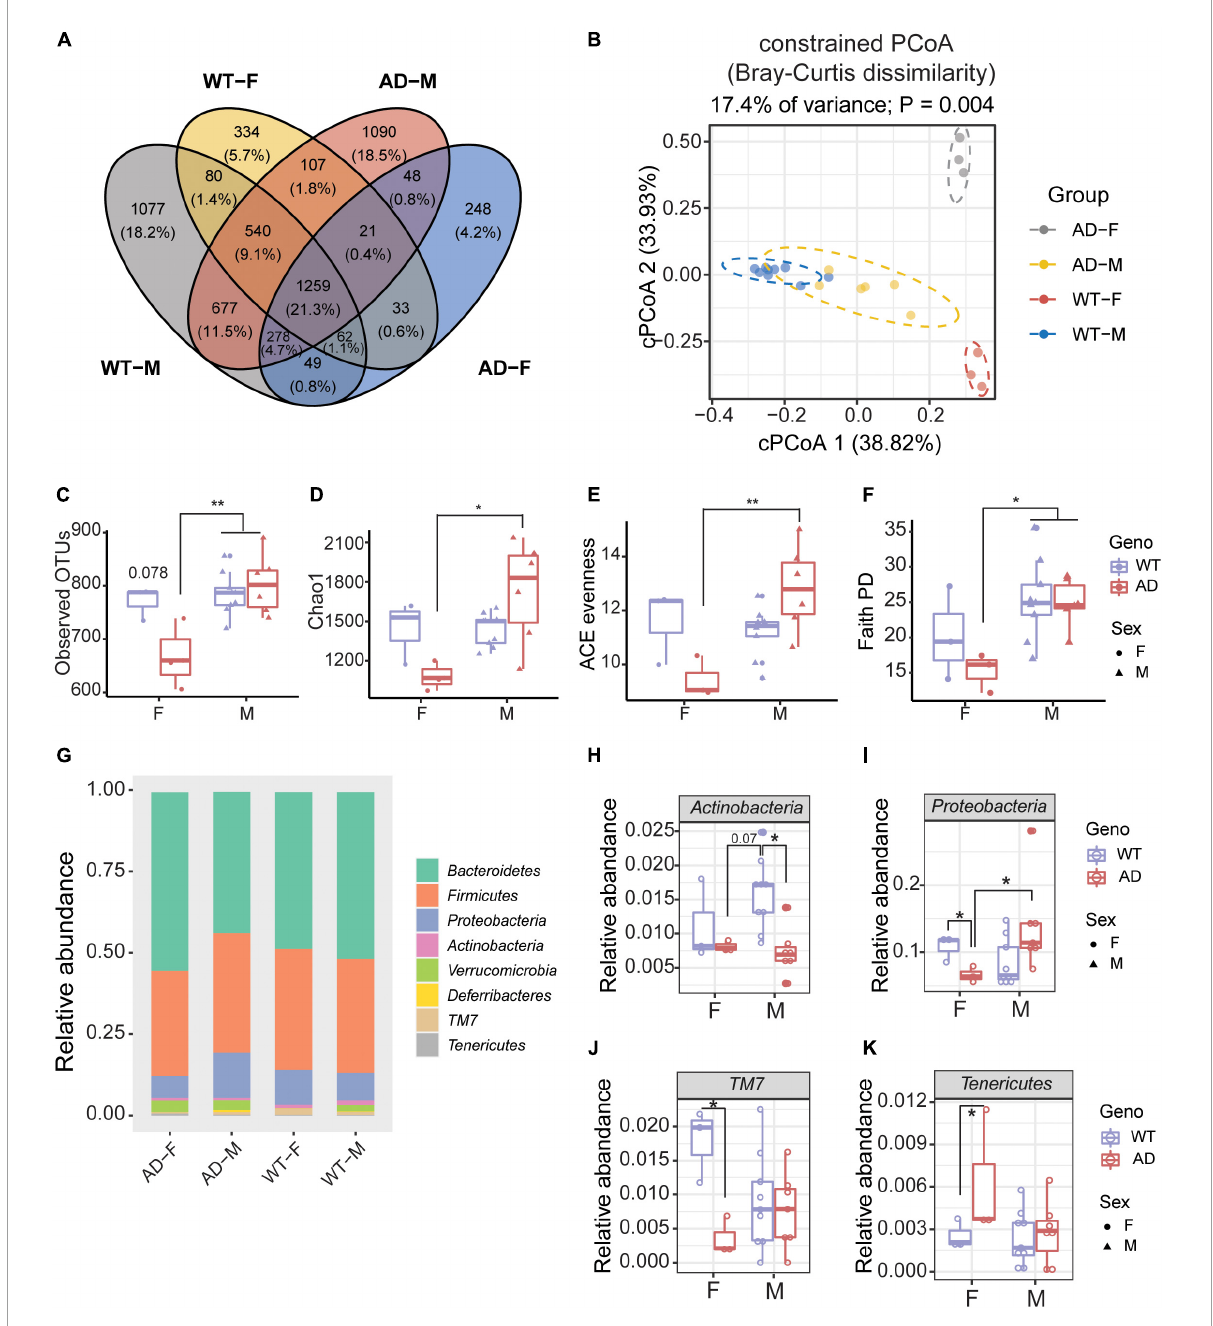
FIGURE4 Sex differences exhibited in the gut microbiome of Alzheimer’s disease (AD) mice. (A) Venn diagram depicting the unique and shared operation taxonomic units (OTUs) between males and females of 2xTg AD and wild-type (WT) mice. (B) Beta diversity is represented by constrained principal coordinate analysis (cPCoA) analysis using genotype as the constraining variable and ordinated with Jaccard dissimilarity. (C,D) The richness of gut microbiome diversity is represented by observed OTUs (C) and Chao1 (D) indices ( n = 3–6). (E,F) The evenness of gut microbiome diversity is represented by ACE evenness (E) and faith PD (F) ( n = 3–6). * P < 0.05, ** P < 0.01; two-way analysis of variance (ANOVA) followed by Tukey’s multiple comparisons. (G) Microbiome composition at the phylum level ( n = 3–6). (H–K) The relative abundance of phyla of male and female mice in both 2xTg AD and WT groups ( n = 3–6). * P < 0.05, ** P < 0.01; two-way ANOVA followed by Tukey’s multiple comparisons. Data are shown as all samples with a boxplot. F, females; M, males. AD, 6 males and 3 females; WT, 9 males and 3 females; all mice were